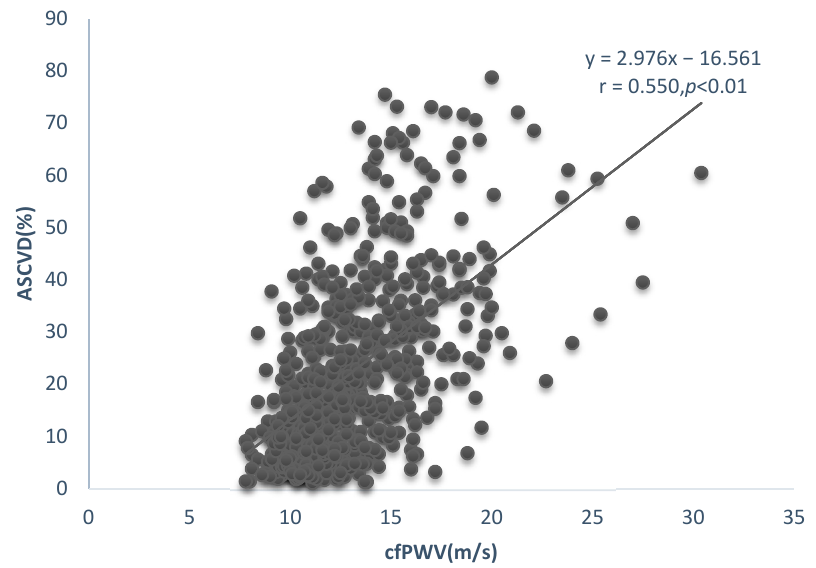
Figure 1. Linear relationship between cfPWV and